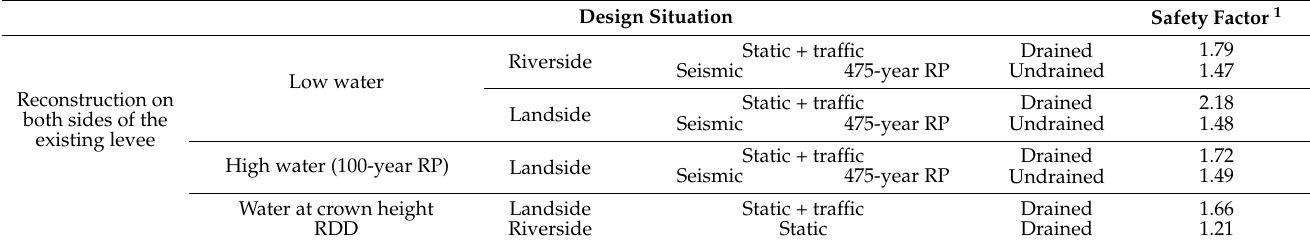
Table 1. Deterministic safety factors for the cross section of interest in various design situations. Design Situation Safety Factor 1